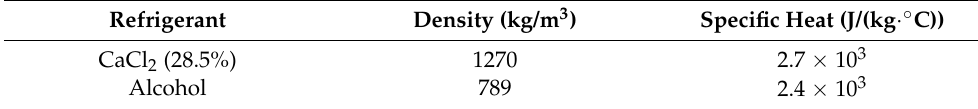
Table 3. Comparison of physical parameters between CaCl 2 and